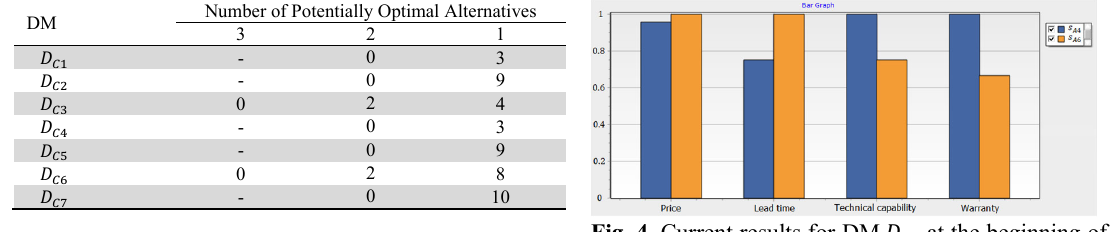
Fig. 4 . Current results for DM 𝐷 elicitation process